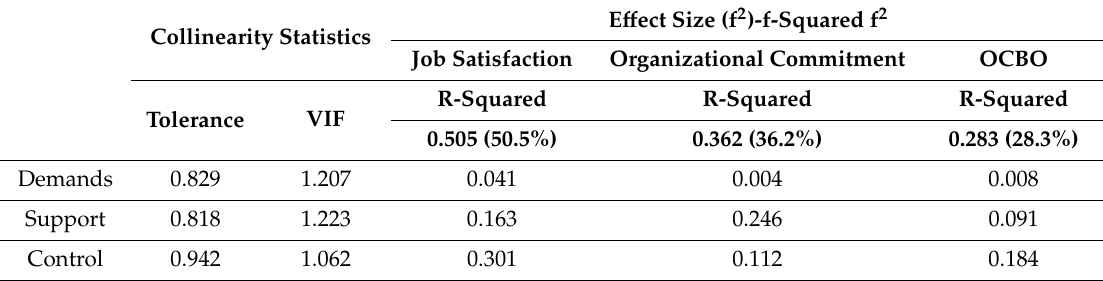
Table 5. Collinearity Statistics and E ff ect Size (f 2